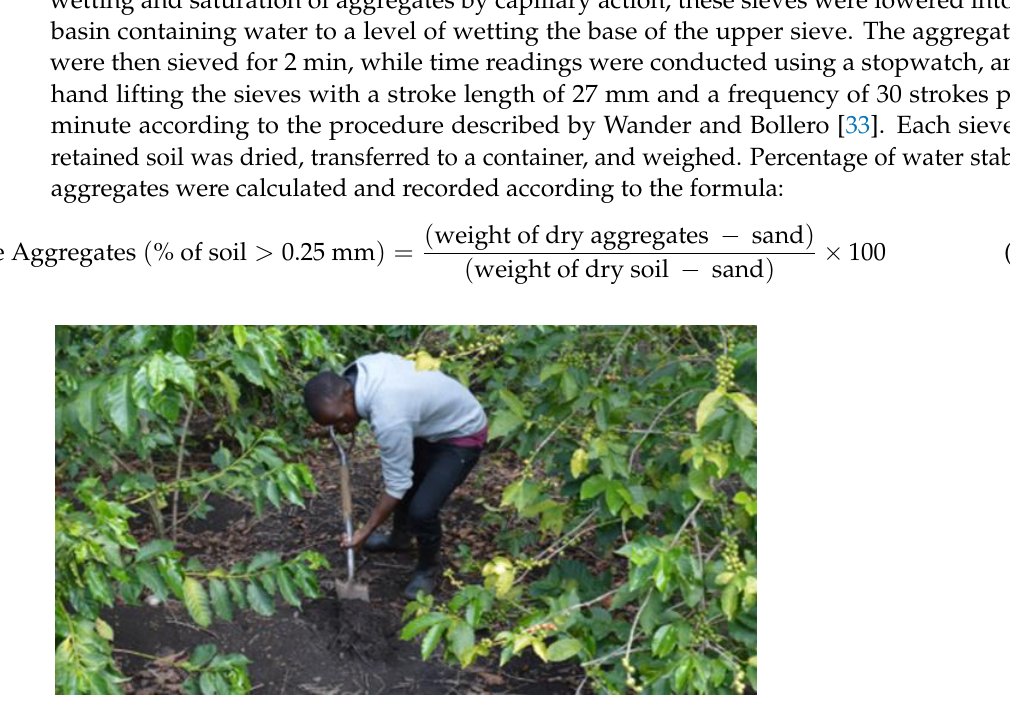
Figure 5. Soil sample collection for aggregate stability analysis.